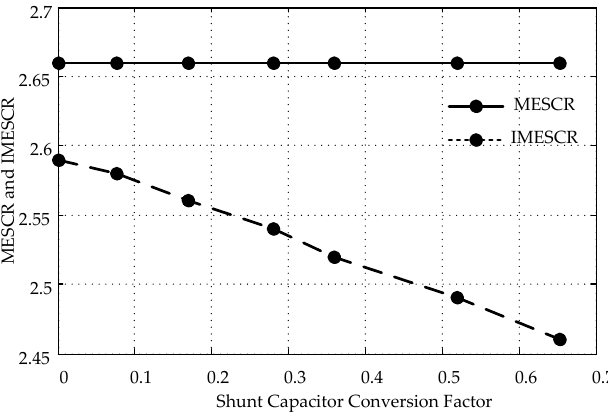
Figure 6. MESCR and IMESCR of the DC inverter bus 35 under different capacitor installation locations.